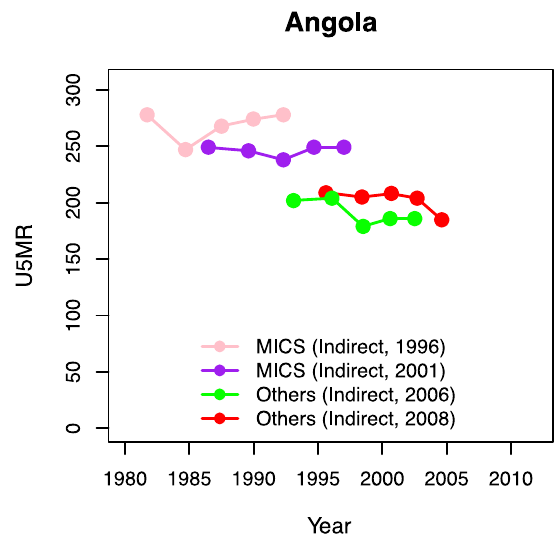
Figure 1. U5MR data series for Angola. Connected dots represent series of indirect estimates of U5MR from birth histories. The source and source date for each series is given in the legend.